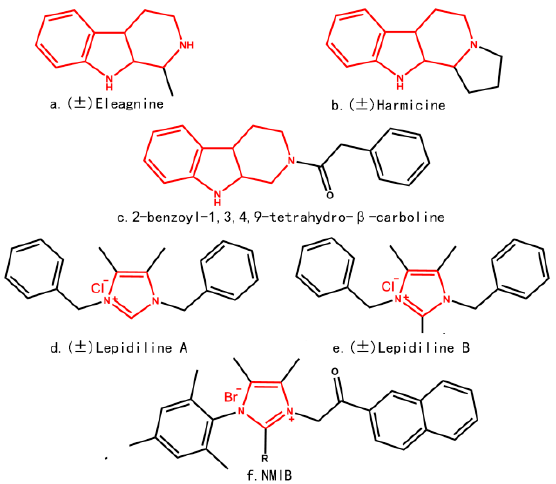
Figure 1. Representative alkaloids with N -substituted tetrahydro- β -carboline and imidazole moieties.